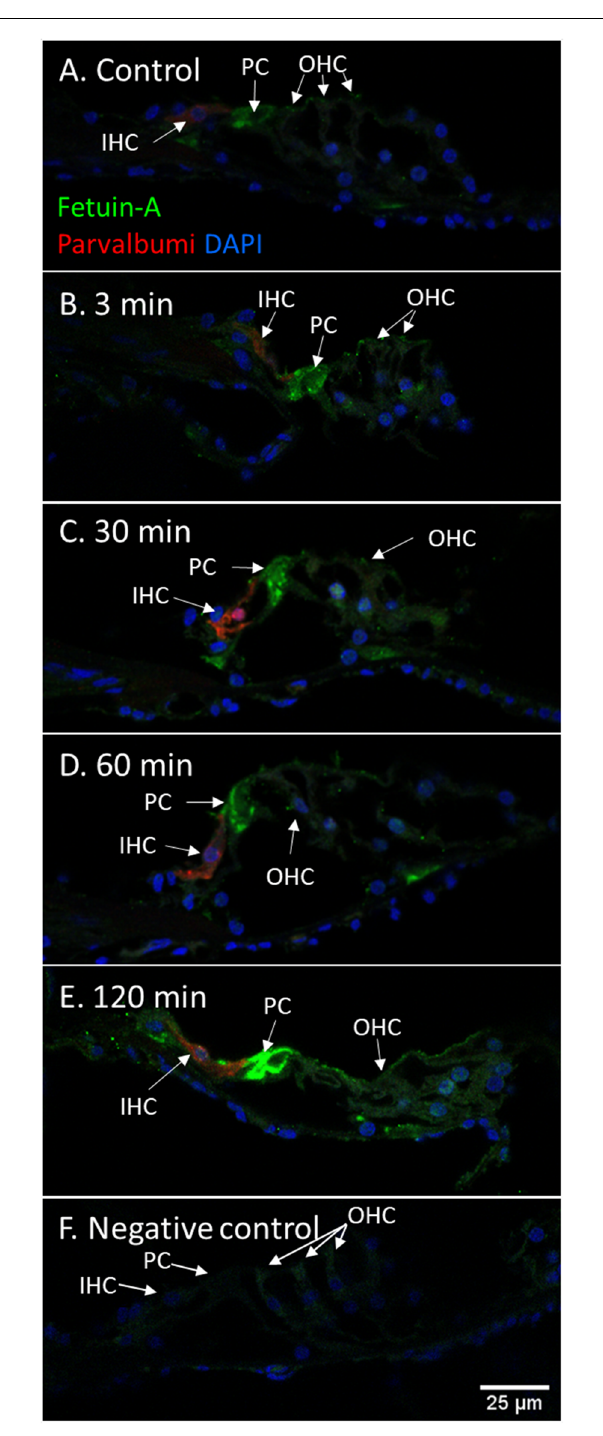
FIGURE 9 | Fetuin-A in the organ of Corti following furosemide injection. (A–F) Fetuin-A protein localization and staining intensity in the guinea pig’s organ of Corti following IV furosemide injection. Parvalbumin stains the IHC red. (A) In the control was Fetuin-A detected in the pillar cells. (B–E) Staining intensity in the guinea pig’s organ of Corti following IV furosemide injection. Fetuin-A staining was greatly increased in the pillar cells, and the IHCs, OHCs, and Deiters were positive after 120 min. (F) Negative control of organ of